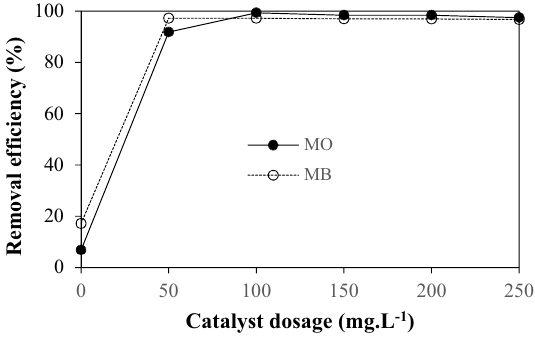
Figure 3: E ff ect of catalyst dosage on the removal e ffi ciency of MO and MB. MO: initial pH 7.0, [ H 2 O 2 ] = 0.2 mol · L − 1 , initial [ MO ] = 10 mg · L − 1 , time = 60 min, and ambient temperature. MB: initial pH 3.0, [ H 2 O 2 ] = 0.2 mol · L − 1 , initial [ MB ] = 10 mg · L − 1 , time = 60 min, and ambient temperature.